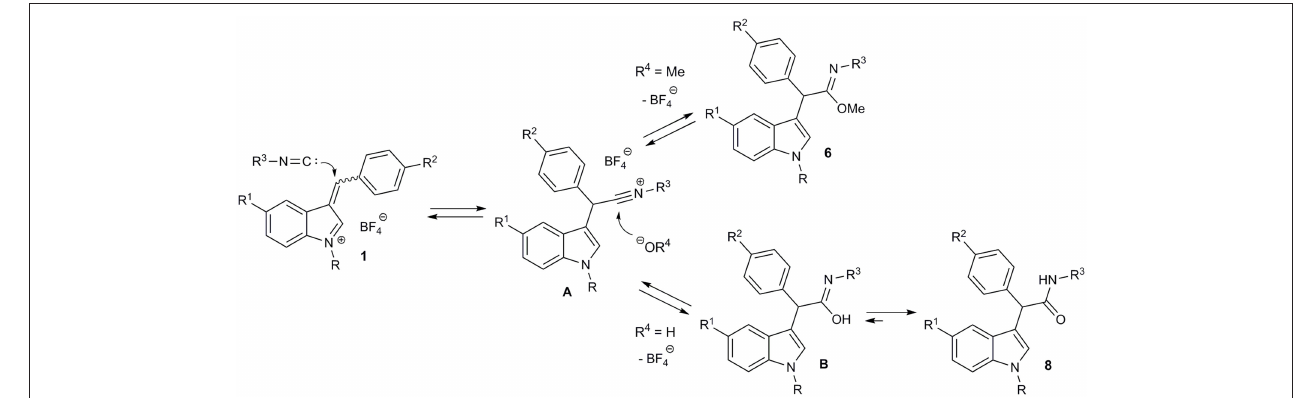
FIGURE 7 | Proposed mechanism of imidates 6 and amides 8